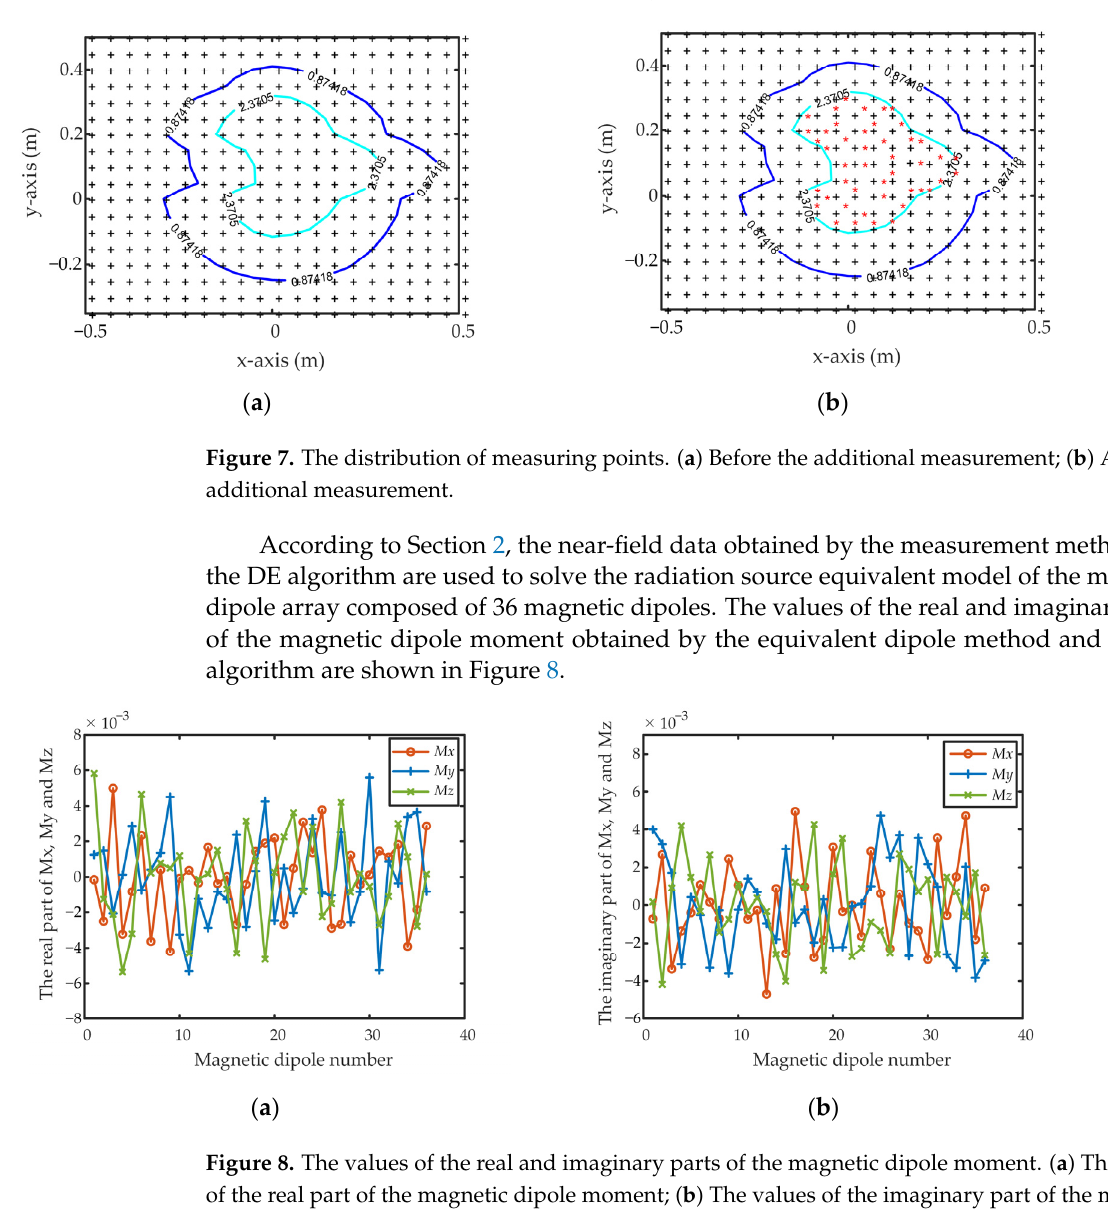
C. The black dots are the locations of sparse and uniform sampling, and the red dots are the positions of the additional measuring points.